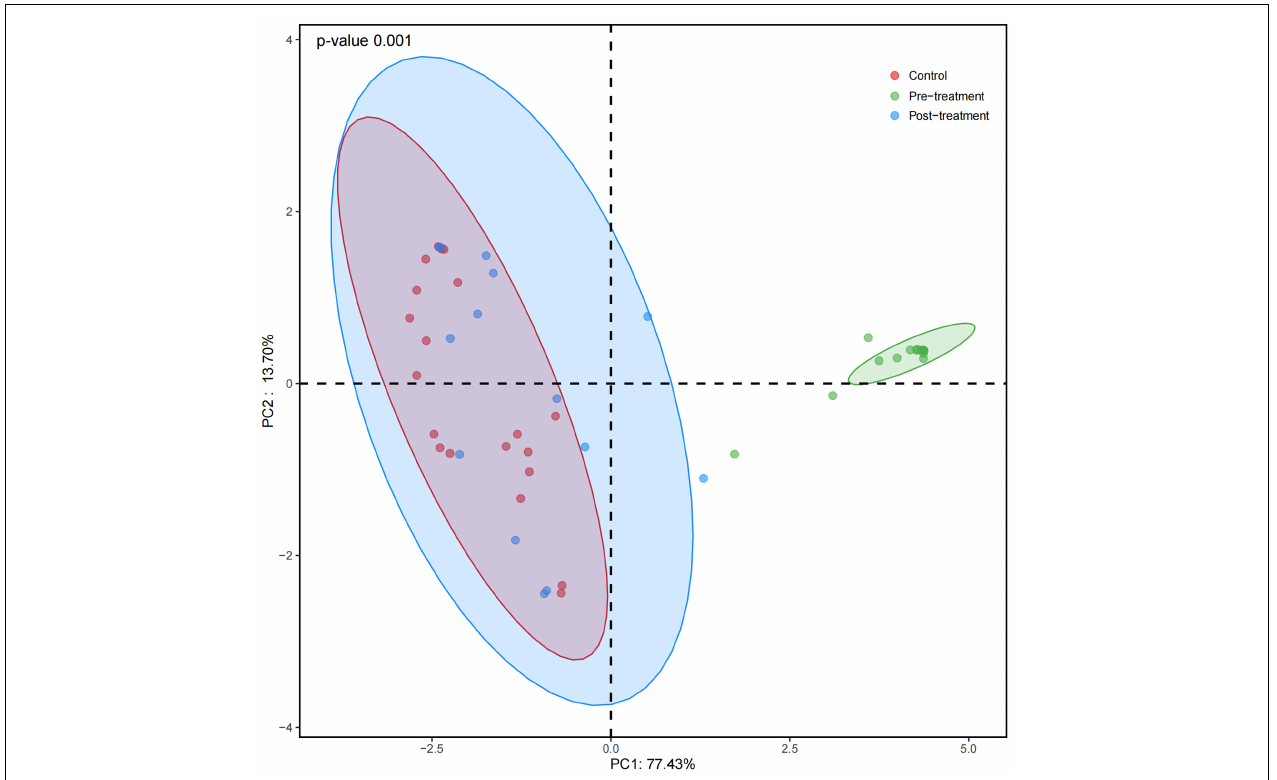
FIGURE 2 | Principal coordinates analysis (PCoA) of fungal composition based on weighted UniFrac in three groups. Red dots refer to the control group. Green and blue dots refer to the pre- and post-treatment groups, respectively. Principal coordinates 1 and 2 explain 77.43% and 13.70% of the variation. PCoA of Bray-Curtis distance indicates no effective discrimination between the control and post-treatment groups. In contrast, the pre-treatment group is discriminated against the control and post-treatment groups.